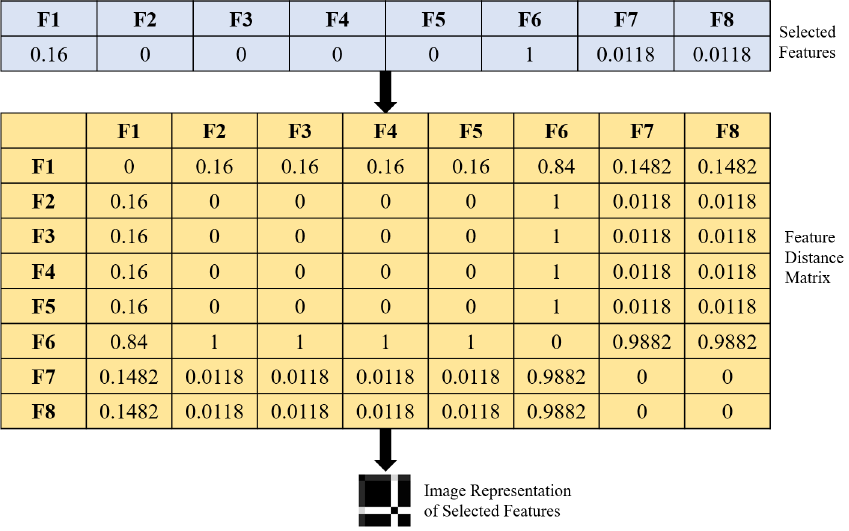
Figure 4. Conversion of selected features to image.